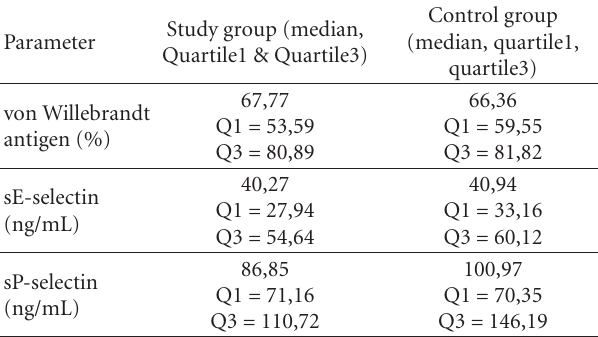
Table 1: Endothelial cell markers in blood plasma of patients with PEX and